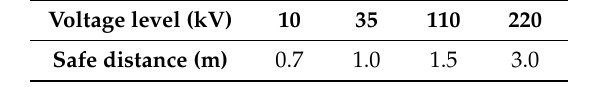
Table 1. Safety distance when power equipment is not powered o ff